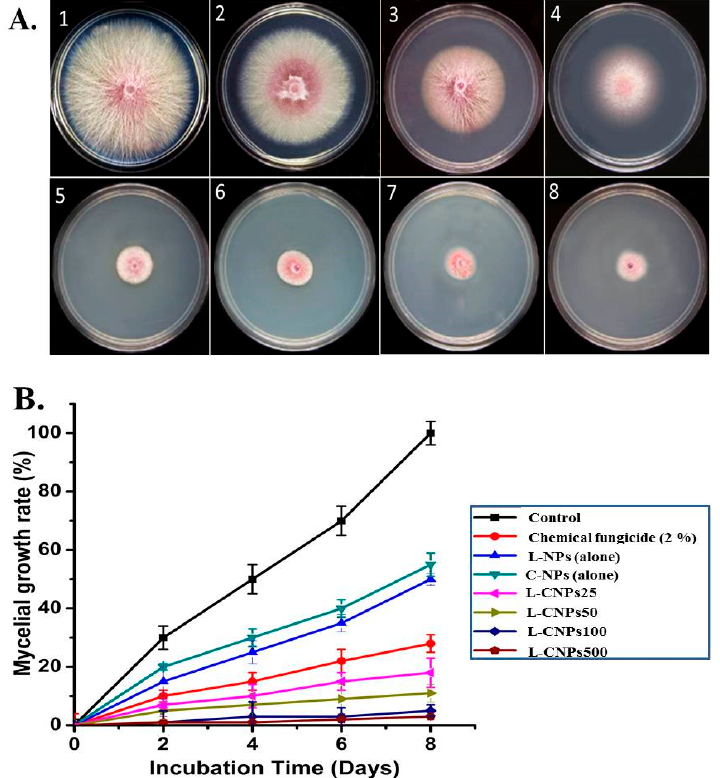
Figure 2. Antifungal activity of L-CNPs against F. verticillioides : ( A ) Mycelial growth inhibition of F. verticillioides on PDA plates after 8 days of incubation: (1) control, (2–4) carbon nanoparticles alone, Lignin nanoparticle alone, and chemical fungicide respectively; (5–8) carbon nanoparticles alone respectively. ( B ) Mycelial inhibition of L-NPs (alone), C-NPs (alone), chemical fungicide (2%), L-CNPs at different concentrations (25, 50, 100, and 500) mg/L and mentioned by L-CNPs25, L-CNPs50, L-CNPs100, and L-CNPs500,